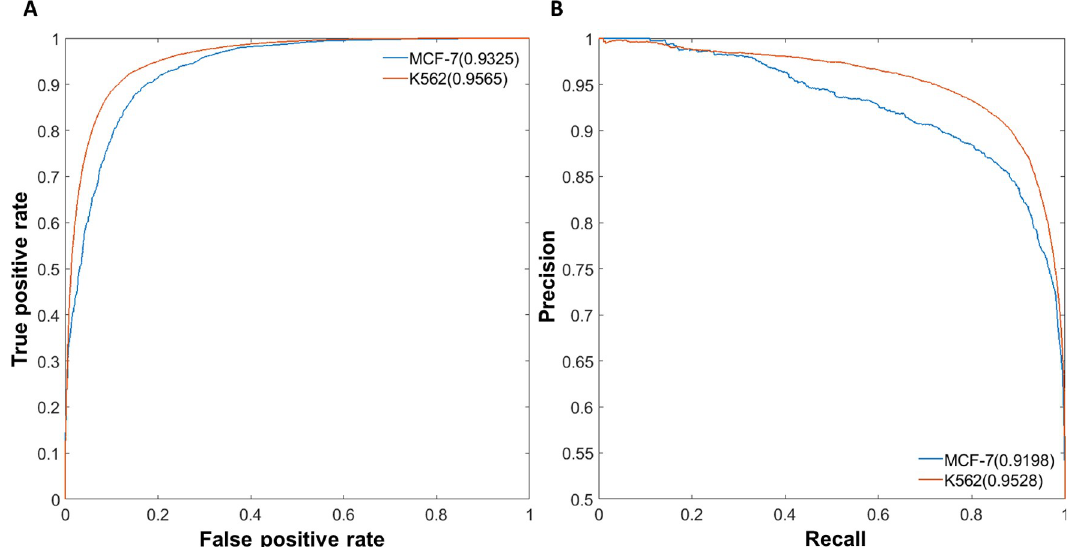
Fig 3. Performance evaluation of EAGLE. We trained an ensemble classifier to predict EG pairs. (A) Performance measurement of self-testing in K562 and MCF-7 by ROC curves. (B) Performance measurement of self-testing in K562 and MCF-7 by PR curves. In each cell line, one half of the data was taken for training, while the other half was used for testing. The performance was measured as the area under ROC or PR curves.